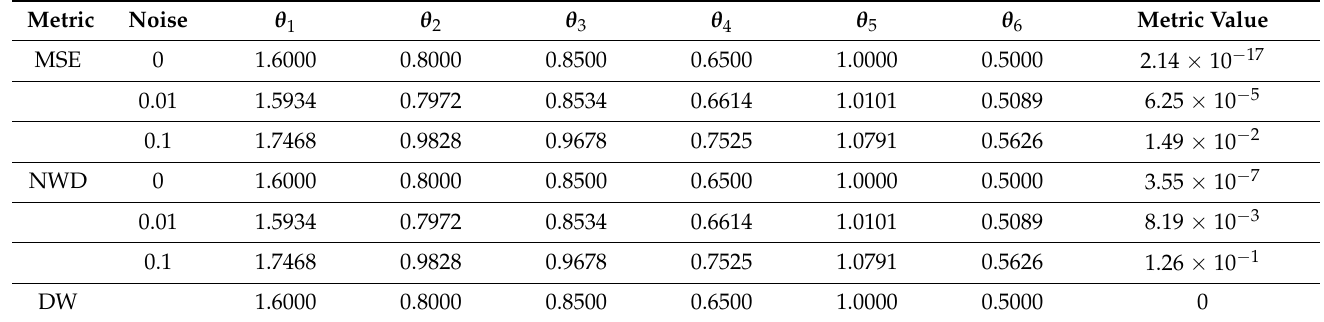
Table 2. Comparison of the estimated parameter values with the actual parameters of Problem